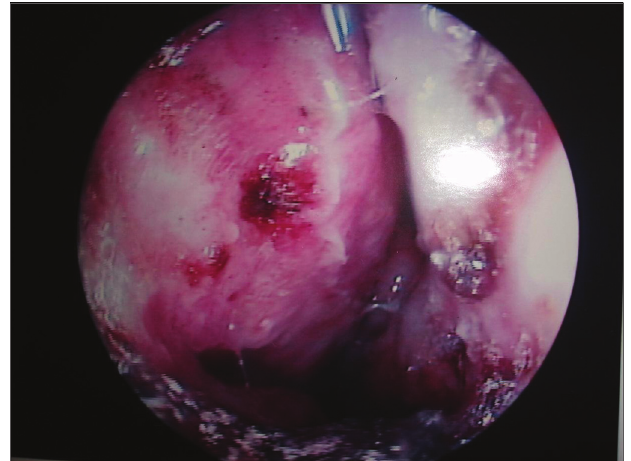
Figura 5. Rinite hansênica - cavidade nasal de paciente controle po- sitivo evidencia à esquerda na endoscopia nasal, infiltração difusa de mucosa, crostas hemáticas e ressecamento.